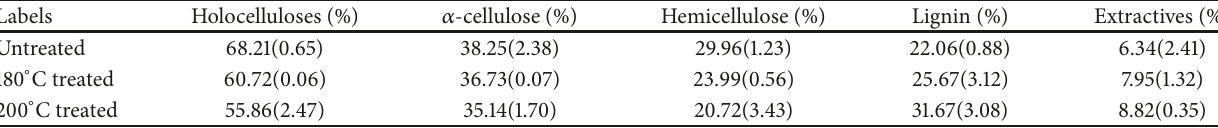
Table 1: Chemical component contents of bamboo during heat